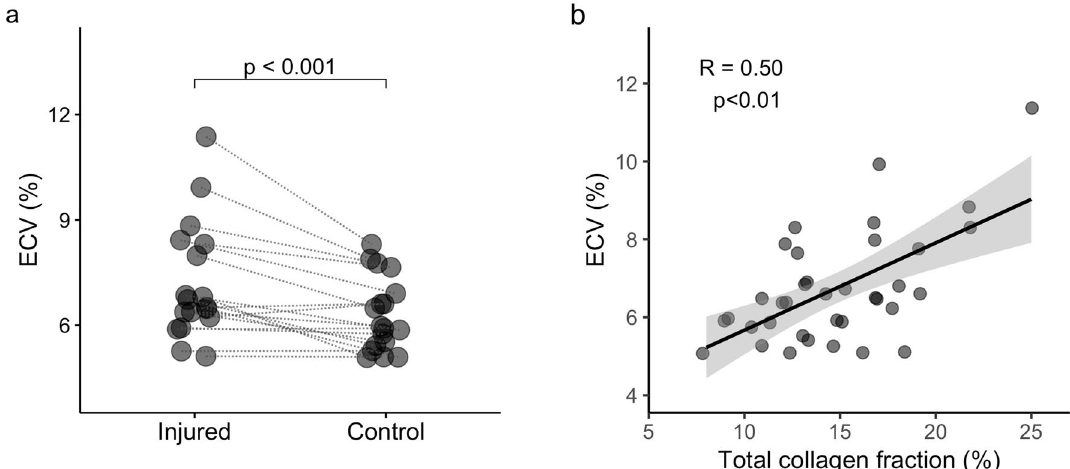
Figure 3. ECV correlates with collagen fraction in skeletal muscles. Extracellular volume (ECV) was estimated from muscle T 1 -maps acquired in vivo and plasma-T 1 measured in samples collected before and 1-h after Gd-CA injection. ECV was higher in fibrotic muscles after injury ( a ) and correlated with collagen fraction ( b ). Lines connect injured and control muscles for each animal in ( a ). ( b ) Scatter plot with fitted linear regression and 95% confidence interval in